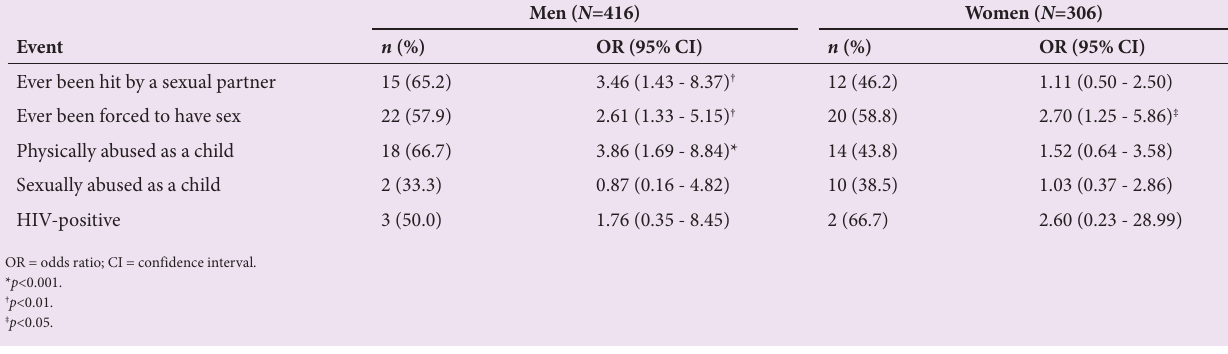
Table 4. Logistic regression analyses predicting HIV risk behaviour Men ( N =416) Women ( N =306) Factor Crude OR (95% CI) Adjusted OR (95% CI) Crude OR (95% CI) Adjusted OR (95% CI)